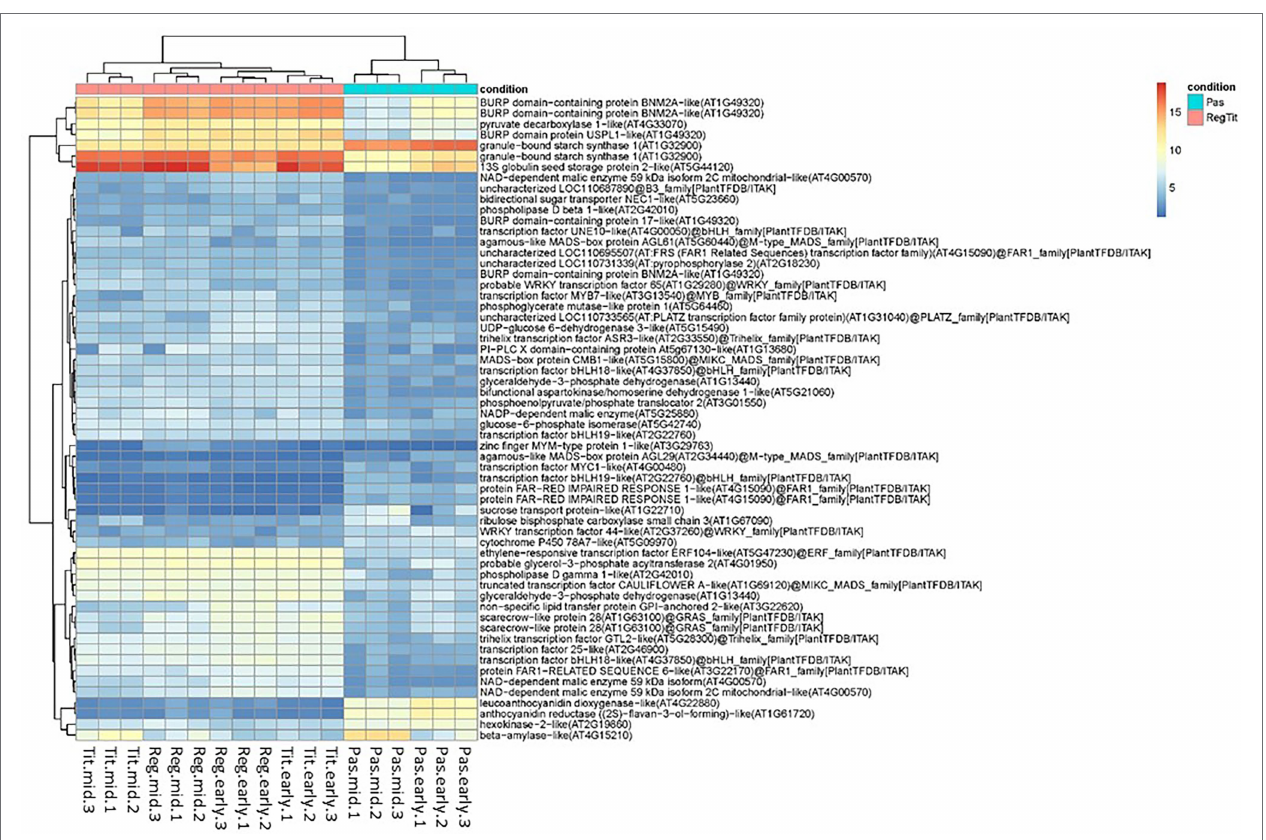
FIGURE 8 | Heat map showing the expression levels of the 60 selected transcripts (rlog normalized scores) in quinoa seeds of potential importance for regulating seed quality in Pasankalla. These selected transcripts encode either functions involved in central carbon metabolism (sugar, starch, lipid, and protein metabolism) or transcription factors, and they all showed at least eight times higher/lower transcript expression (log2FC > 3.0, value of p ≤ 0.01) in Pasankalla (Pas, turquiose) as compared to in Regalona and Titicaca (RegTit, pink). Expression levels shown are normalized raw read counts (as from the mapping onto the reference genome) using regularized logarithm (rlog). Values are shown from triplicate biological samples from the early and mid-developmental stages (for corresponding dpa, see the